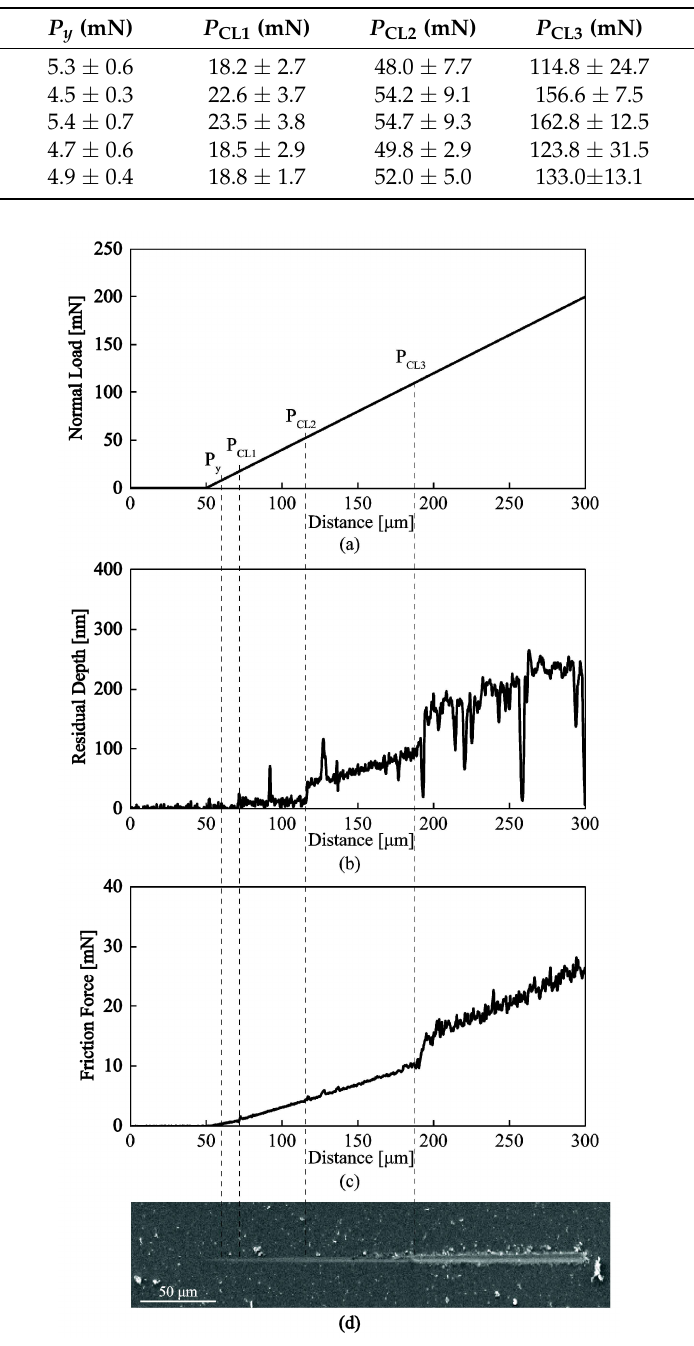
Figure 9. Typical results from a nanoscratch test on a–C:H film. ( a ) Applied load; ( b ) residual depth and ( c ) resulting frictional force as a function of the scratch distance; ( d ) SEM image of the residual nanoscratched